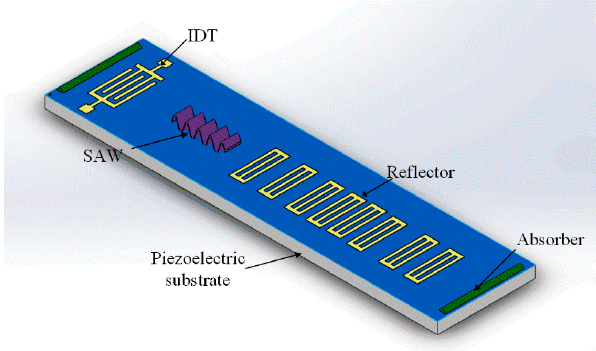
Figure 2. Schematic diagram of the wireless and passive SAW temperature sensor